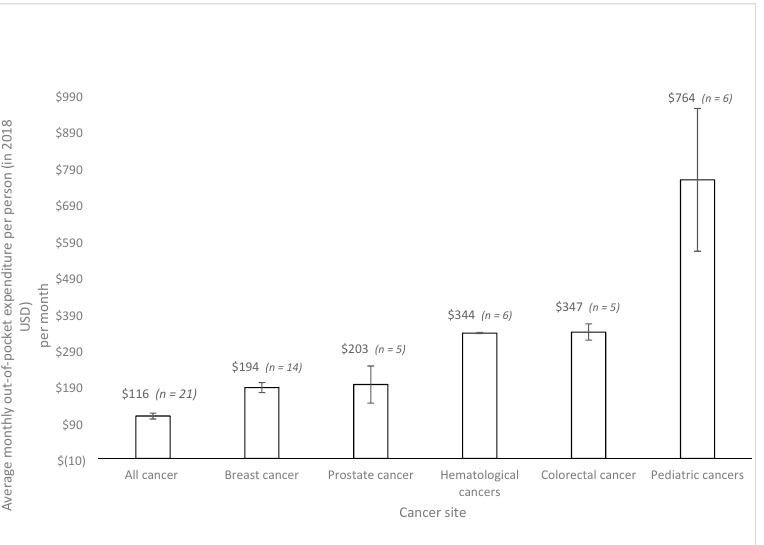
Figure 4. Average monthly out-of-pocket costs per patient by cancer site with 95% confidence intervals from high-income countries. Note: Studies that included patients with multiple cancer sites are reported under the ‘All cancer’ and ‘pediatric cancer’ categories. Costs are expressed in 2018 USD. Not enough data were available to report average costs per cancer site for low- and middle-income countries, or for individual high-income countries. Curr. Oncol. 2021 , 28